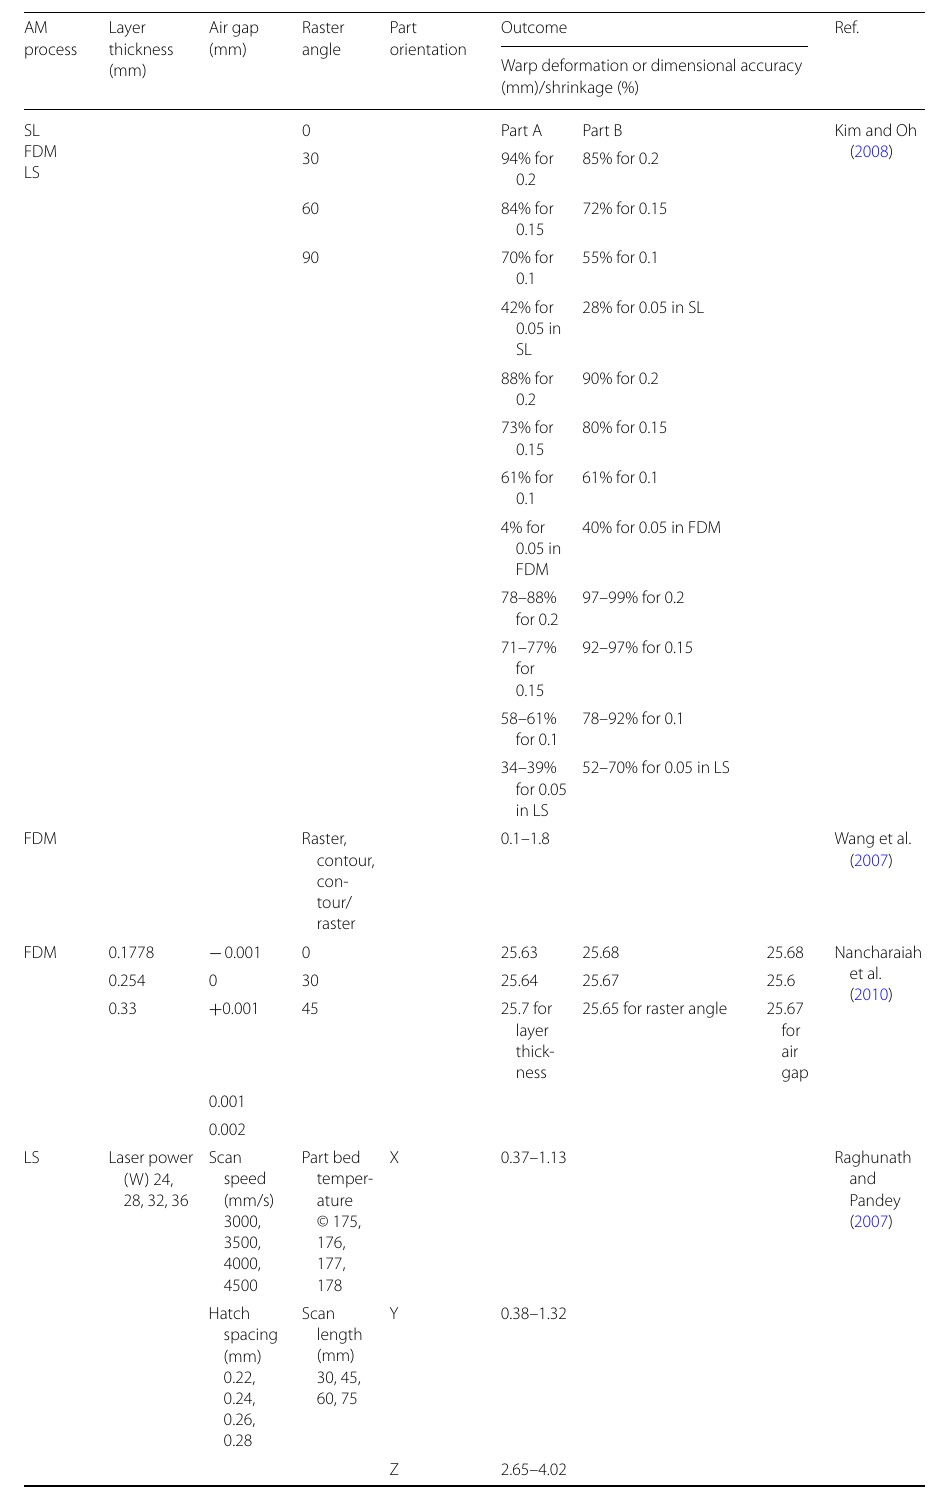
Table 3 Influential AM parameters on dimensional